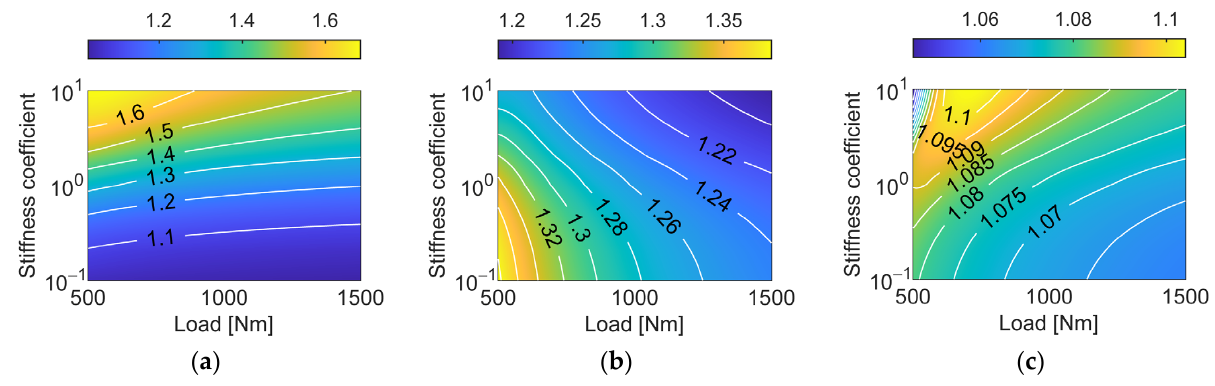
Figure 14. In fl uence of support sti ff ness of Input Gear 1 on load-sharing coe ffi cient: ( a ) Input Gear Figure 14. Influence of support stiffness of Input Gear 1 on load-sharing coefficient: ( a ) Input Gear 1; 1; ( b ) Input Gear 2; ( c ) idler gear. ( b ) Input Gear 2; ( c ) idler